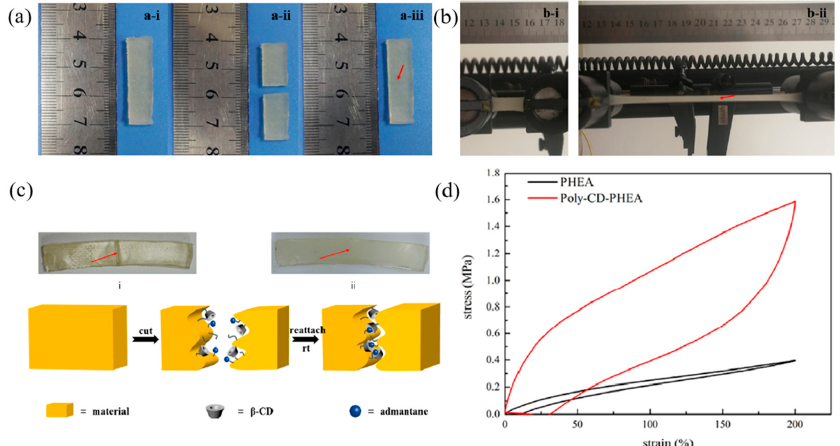
Figure 24. The self-healing of polycyclodextrin elastomer system with host–guest interaction; ( a ) photographs of healing process before and after healing time for 24 h, ( b ) photographs of healed sample under tension, ( c ) typical mechanism for self-healing materials, and ( d ) tensile loading- unloading curves of the toughening elastomers [115]. Adapted with permission from [115]. Copyright 2019 American Chemical